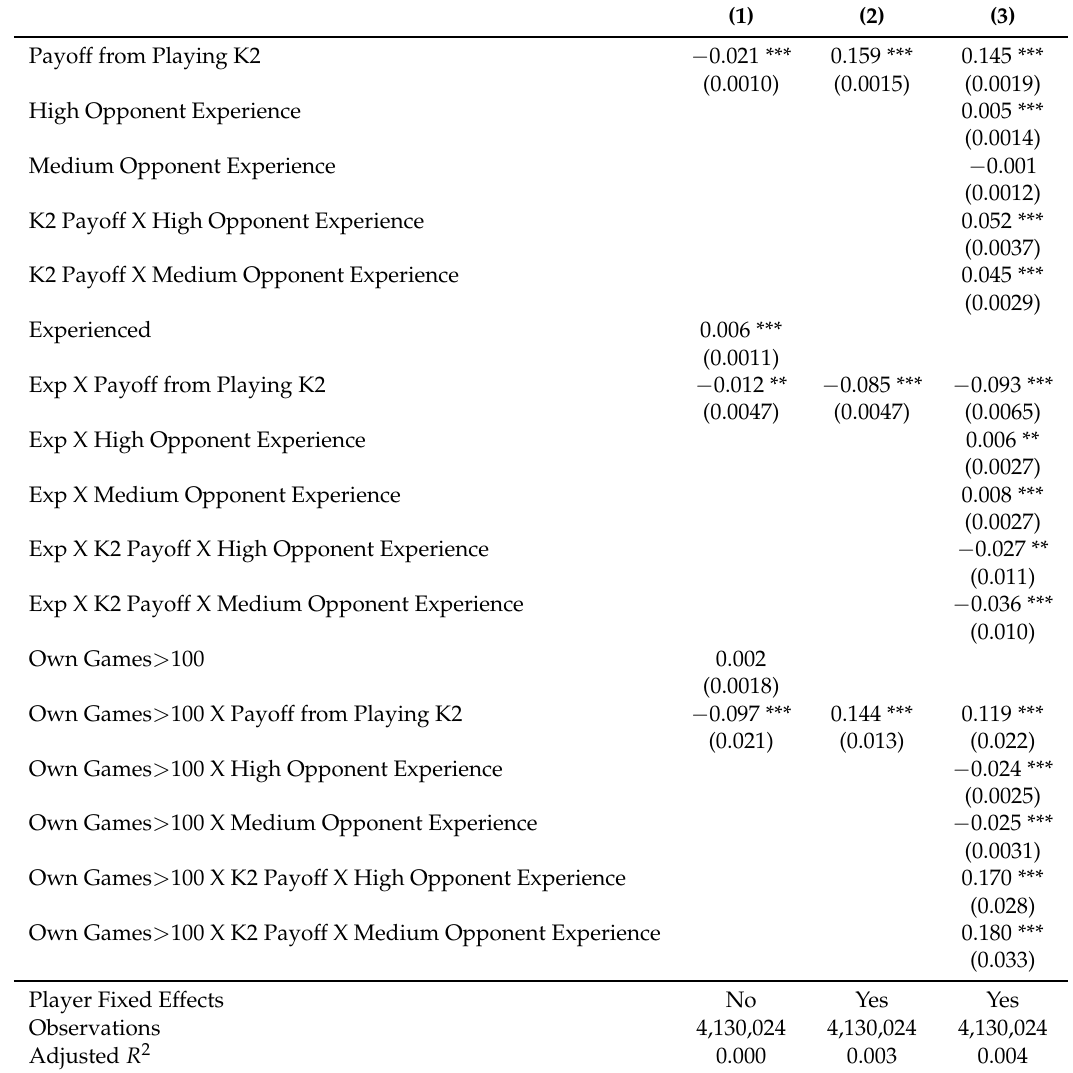
Table A8. Effect of Expected k 2 Payoff on k 2 -Consistency